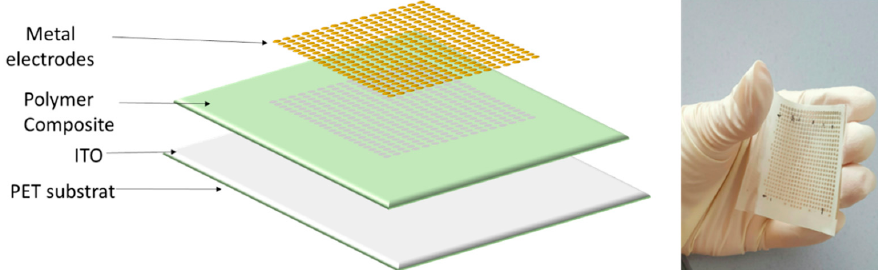
Figure 8. Flexible photodetector arrays, consisting of Indium Tin Oxide (ITO)-coated Polyethylene Terephthalate (PET)/polymer composite/Au electrode.